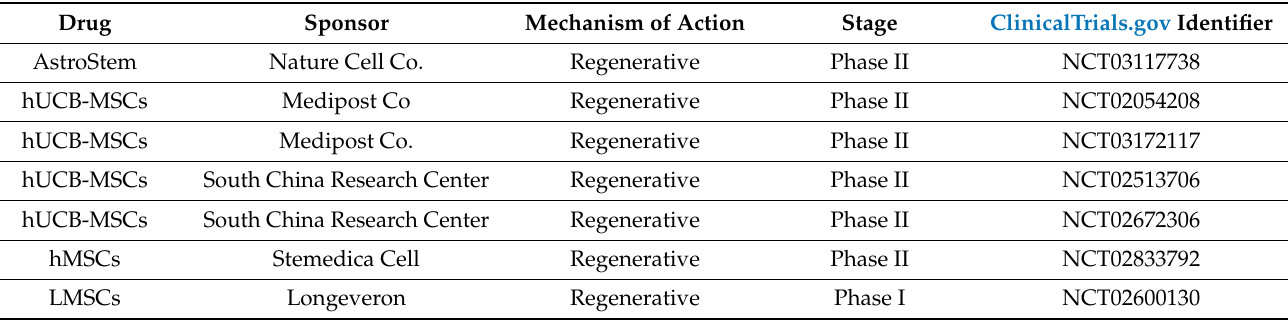
Table 12. Current Stem Cell Therapies for AD